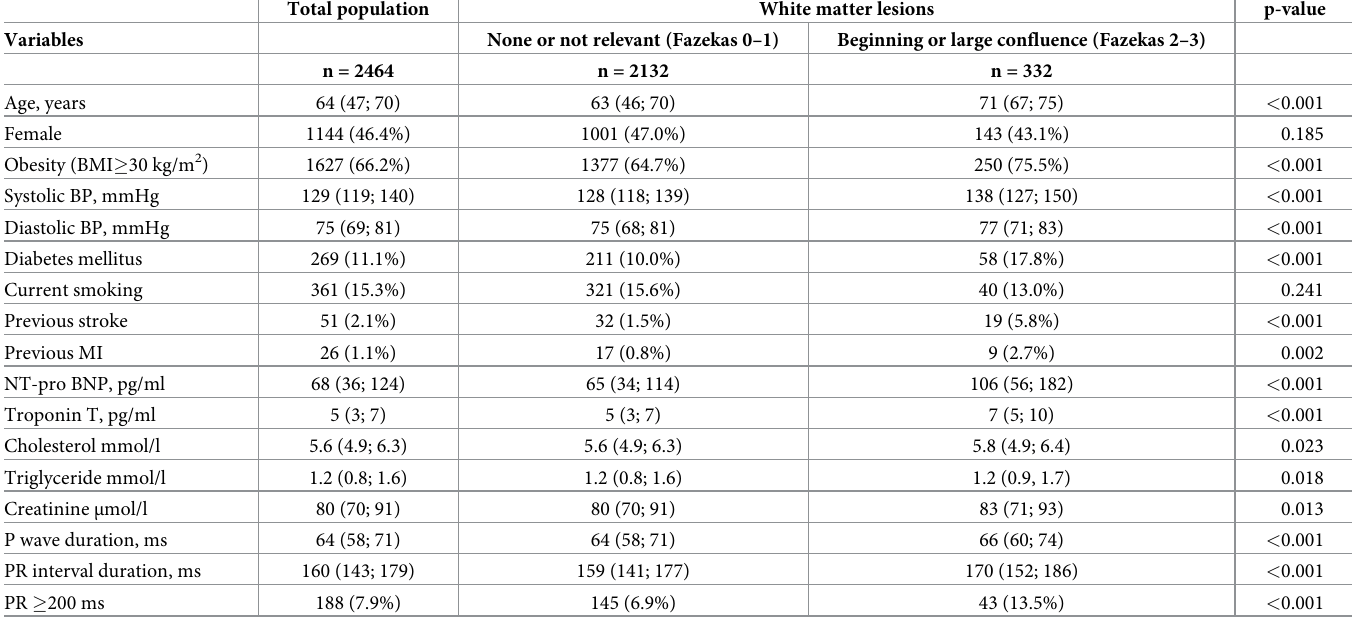
Table 1. Baseline characteristics of the study